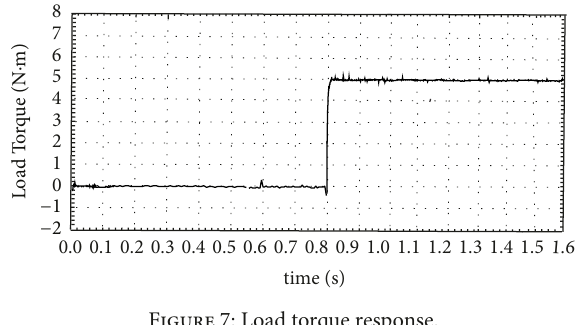
Figure 7: Load torque response.